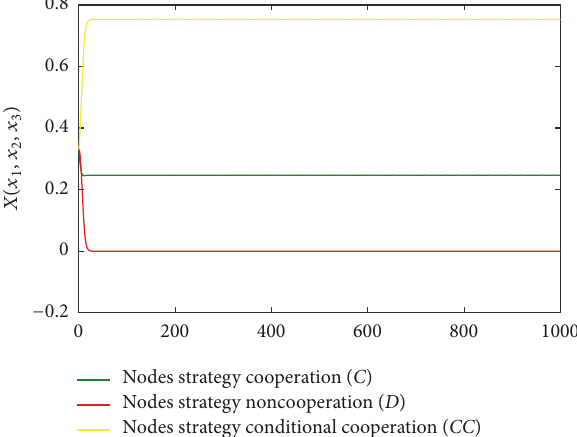
Figure 23: The state of population when 𝐶 𝐶 = 0.000001 and 𝑥 = (0.33, 0.33,